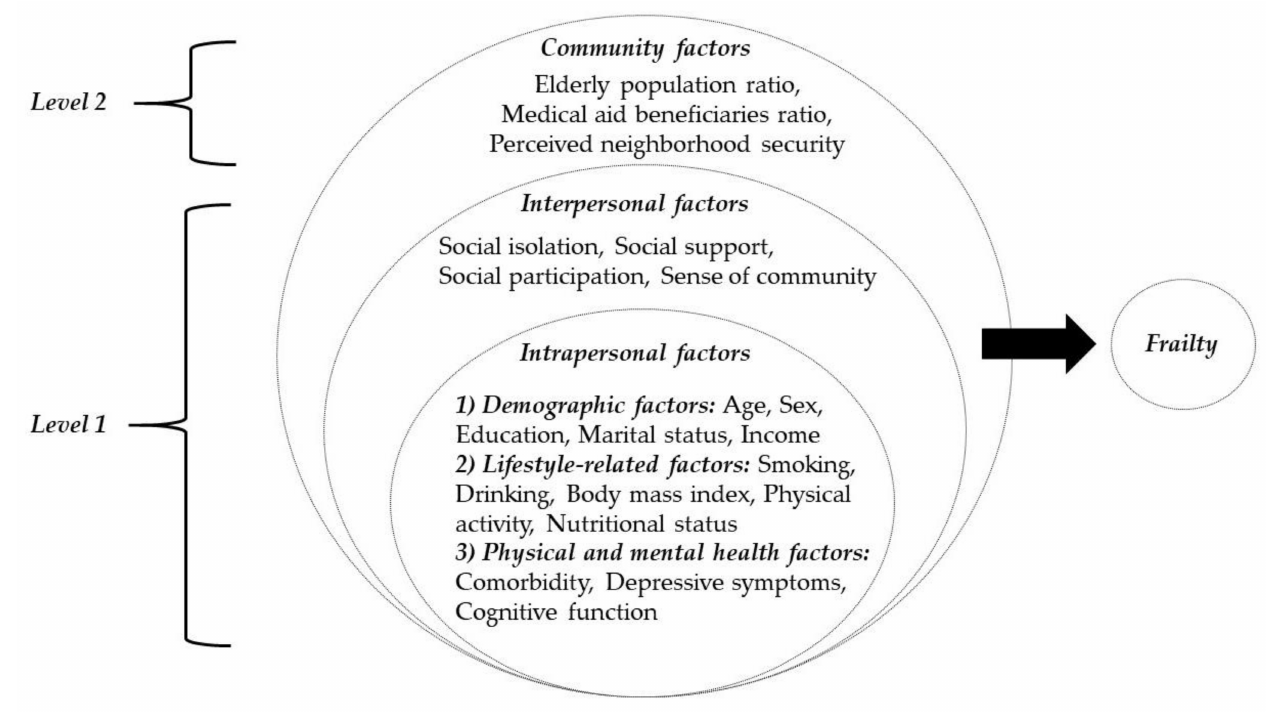
Figure 1. The conceptual framework of this